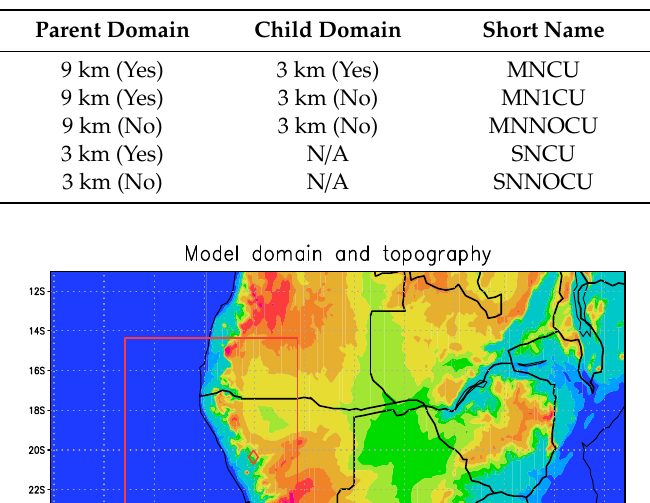
Table 1. Sensitivity tests for the WRF simulations at 9 km and 3 km domains with the convection scheme switched on represented by Yes and off, represented by No.